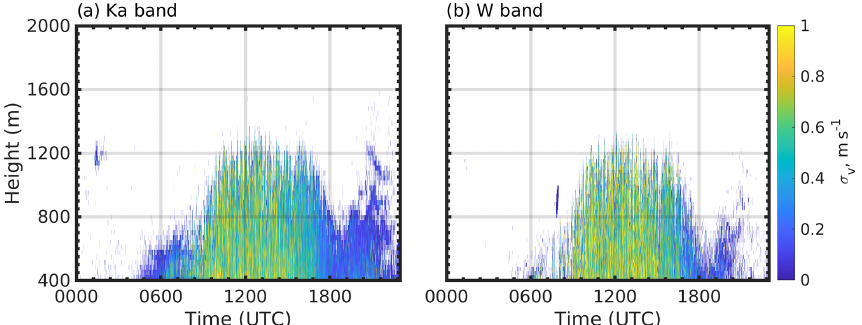
Figure 5. The 1 standard deviation of a mean vertical velocity for the (a) Ka-band and (b) W-band radars for 9 May 2018. Lower values ( < 0.5ms − 1 ) suggest actively flying insects, while high values indicate small passive flying insects.